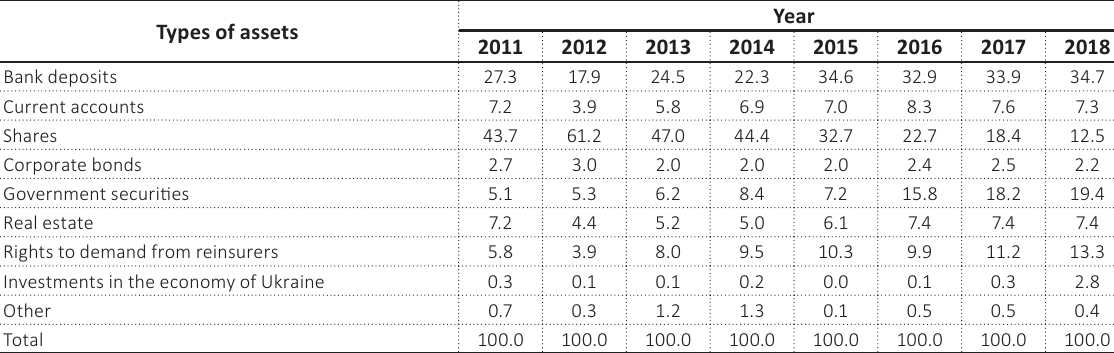
Table 2. Structure of total investment assets of Ukrainian IC in 2011–2018,